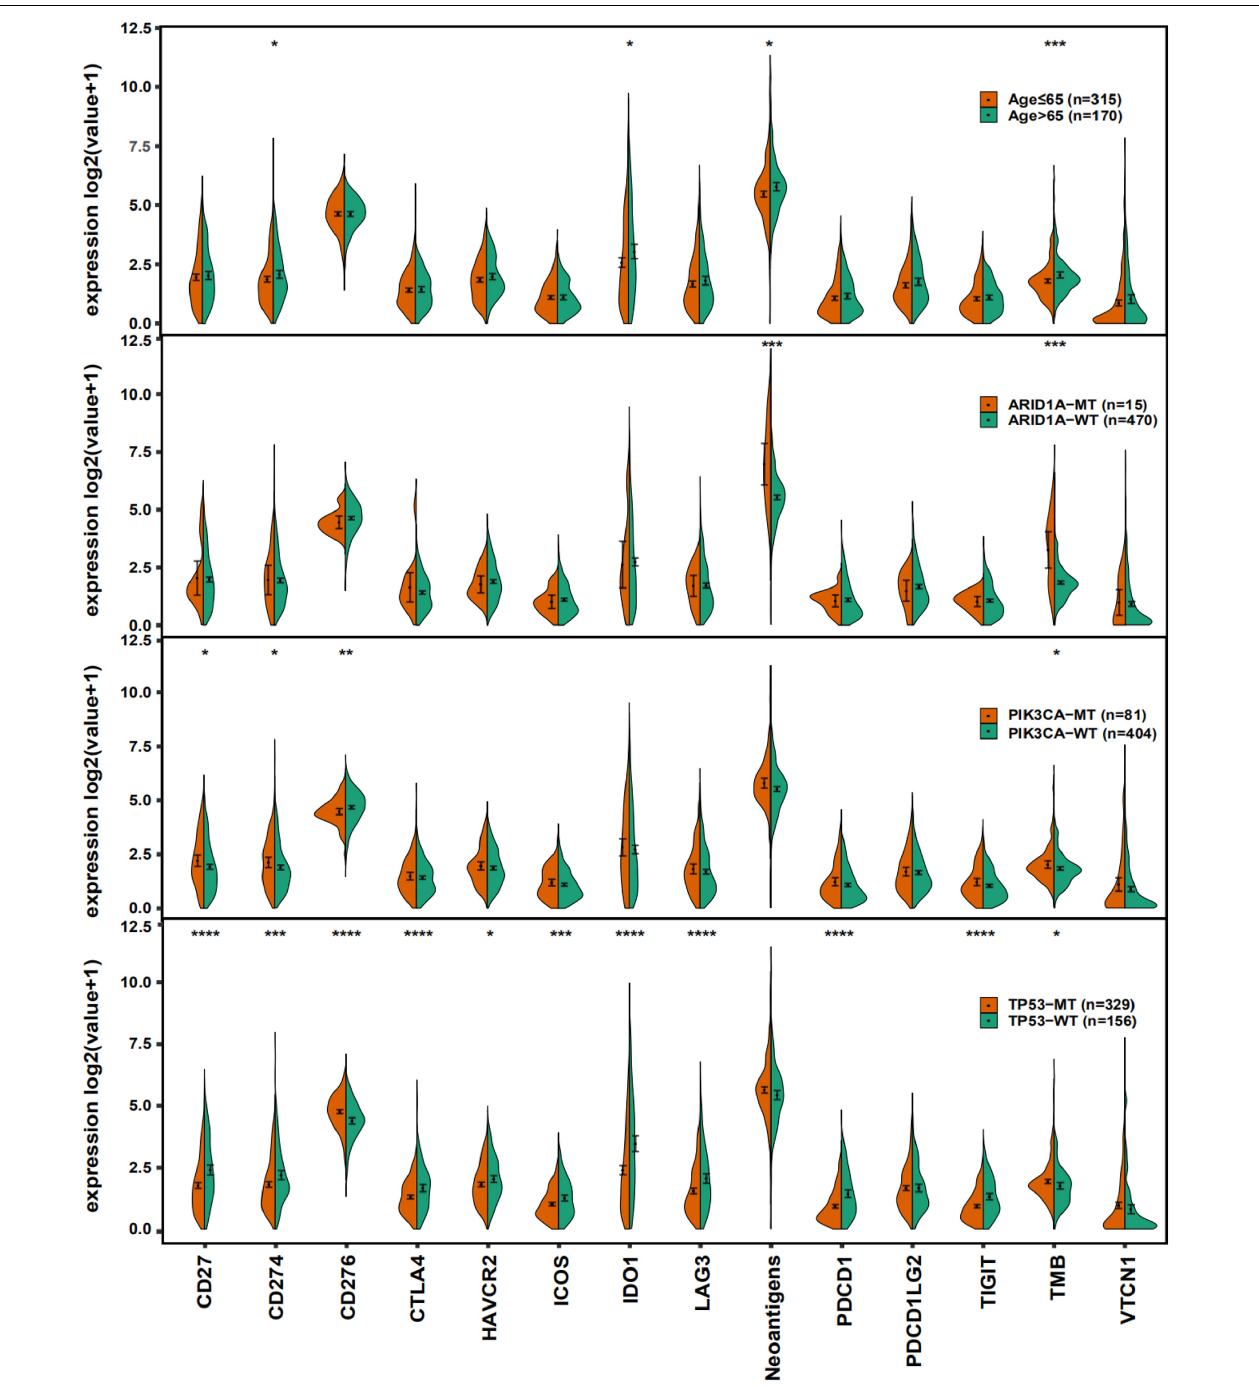
FIGURE 4 | Violin plots showing the expression of immune checkpoint molecules, neoantigen load and TMB. The range of p -values is represented by the asterisks above each violin plot (* P ≤ 0.05; ** P ≤ 0.01; *** P ≤ 0.001; **** P ≤ 0.0001).